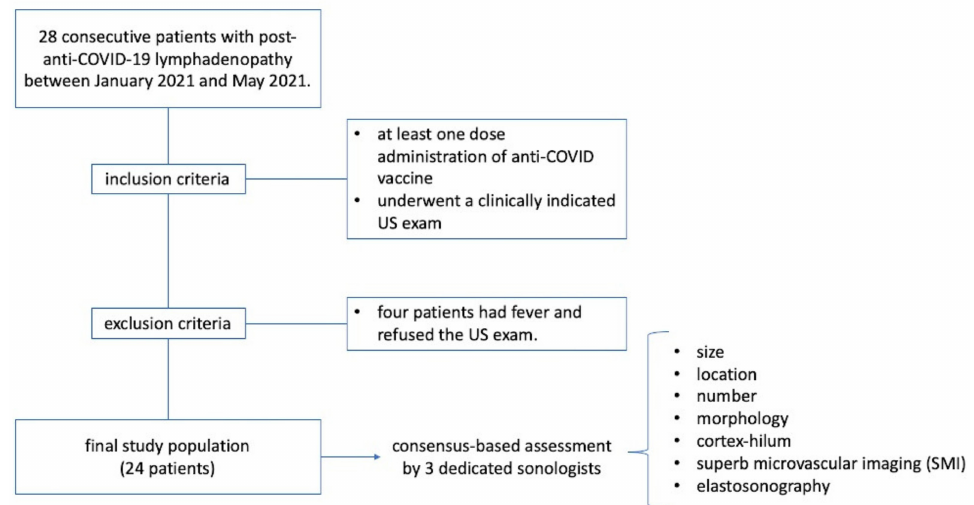
Figure 1. Flowchart summarizing